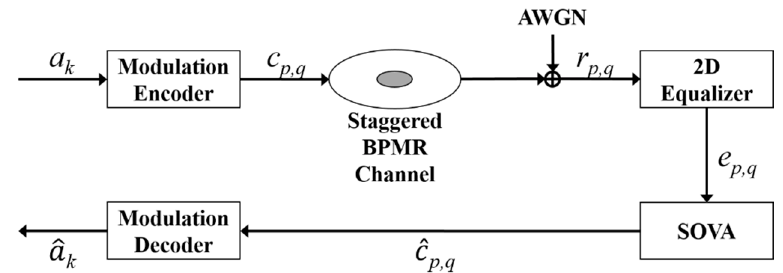
Figure 2. Block diagram of the proposed system model.